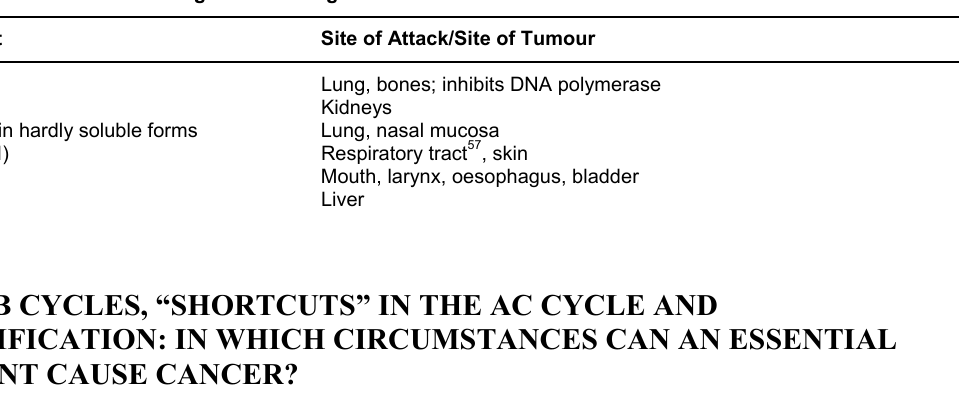
TABLE 3 Inorganic Carcinogens and Their Mode and Site of